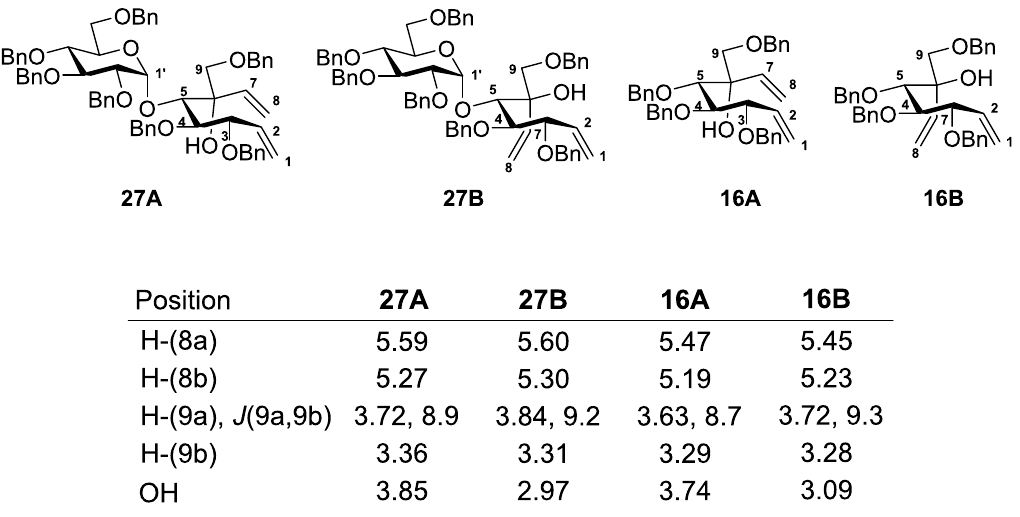
Table 1. Selected 1 H NMR shift values (ppm) of compound 27A , 27B , 16A , and 16B